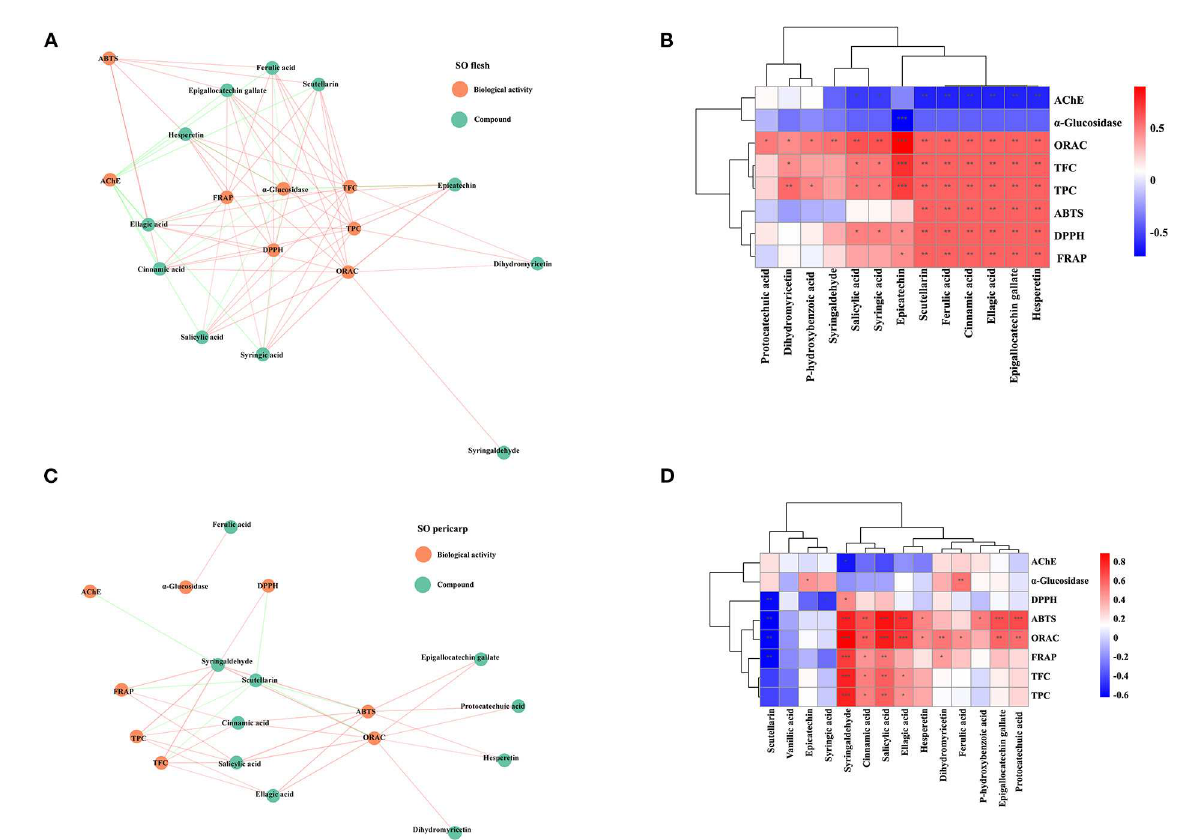
FIGURE7 The correlation with compounds from crude extracts and fractions of SO and their biological activities. (A) Correlation heat map of SO flesh; (B) Correlation network diagram of SO flesh; (C) Correlation heat map of SO pericarp; (D) Correlation network diagram of SO pericarp. Each line connects the bioactivity or interphase of the compound p < 0.05. P-value (ranging from − 1 to 1) and corresponding color (blue to red), p < 0.05 was considered as significant (*), p < 0.01 as highly significant (**), and p < 0.001 as very significant (***). SO, Stauntonia obovatifoliola ; TPC, total phenolic content; TFC, total flavonoid content; DPPH, DPPH · scavenging activity; ABTS, ABTS · + scavenging ability; FRAP, the ferric reducing antioxidant power; ORAC, oxygen radical absorbance capacity; α -glucosidase, the IC 50 value for α -glucosidase inhibitory; AChE, the IC 50 value for acetylcholinesterase